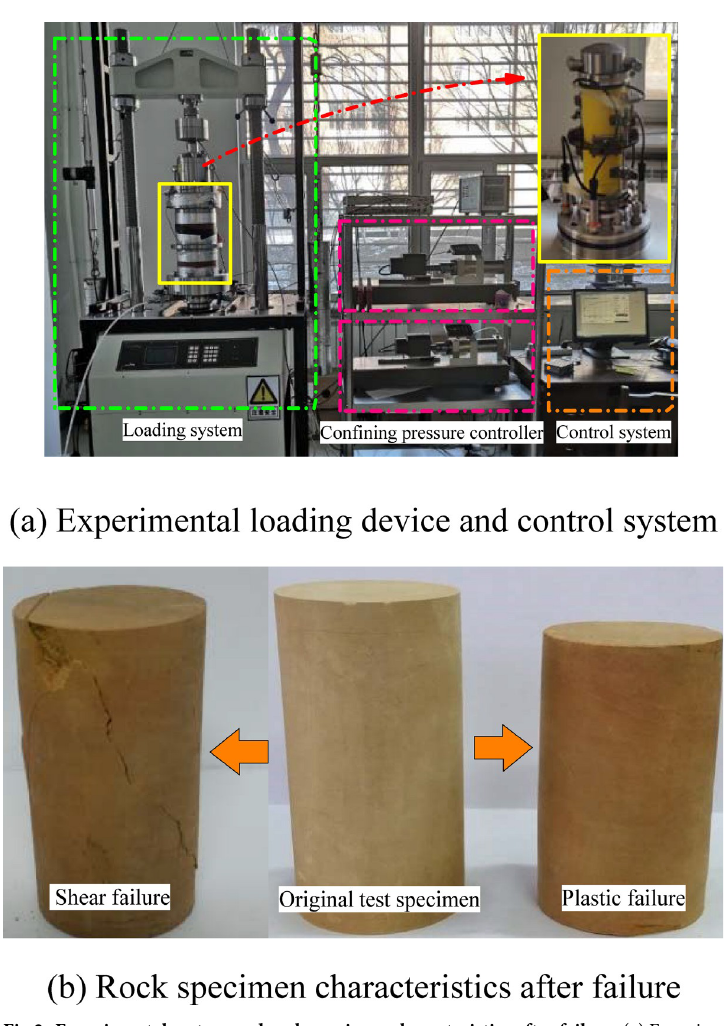
Fig 2. Experimental system and rock specimen characteristics after failure. (a) Experimental loading device and control system (b) Rock specimen characteristics after failure.